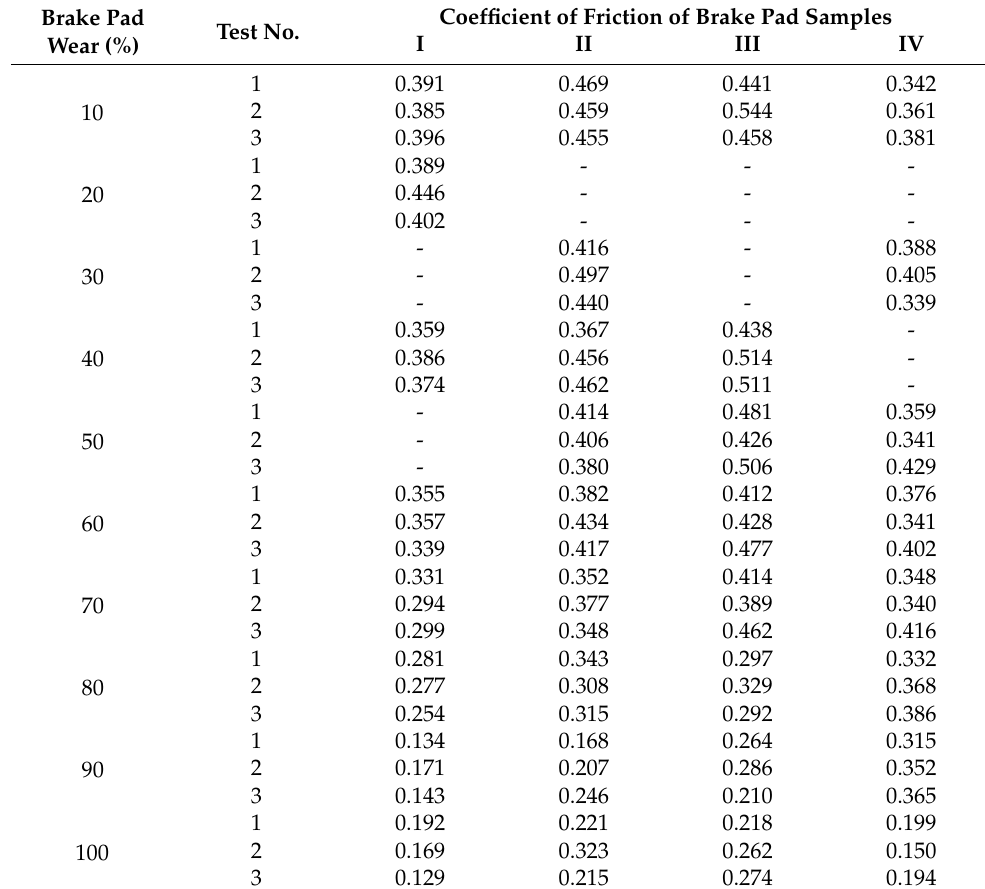
Table 4. Calculated coefficients of friction for particular samples.